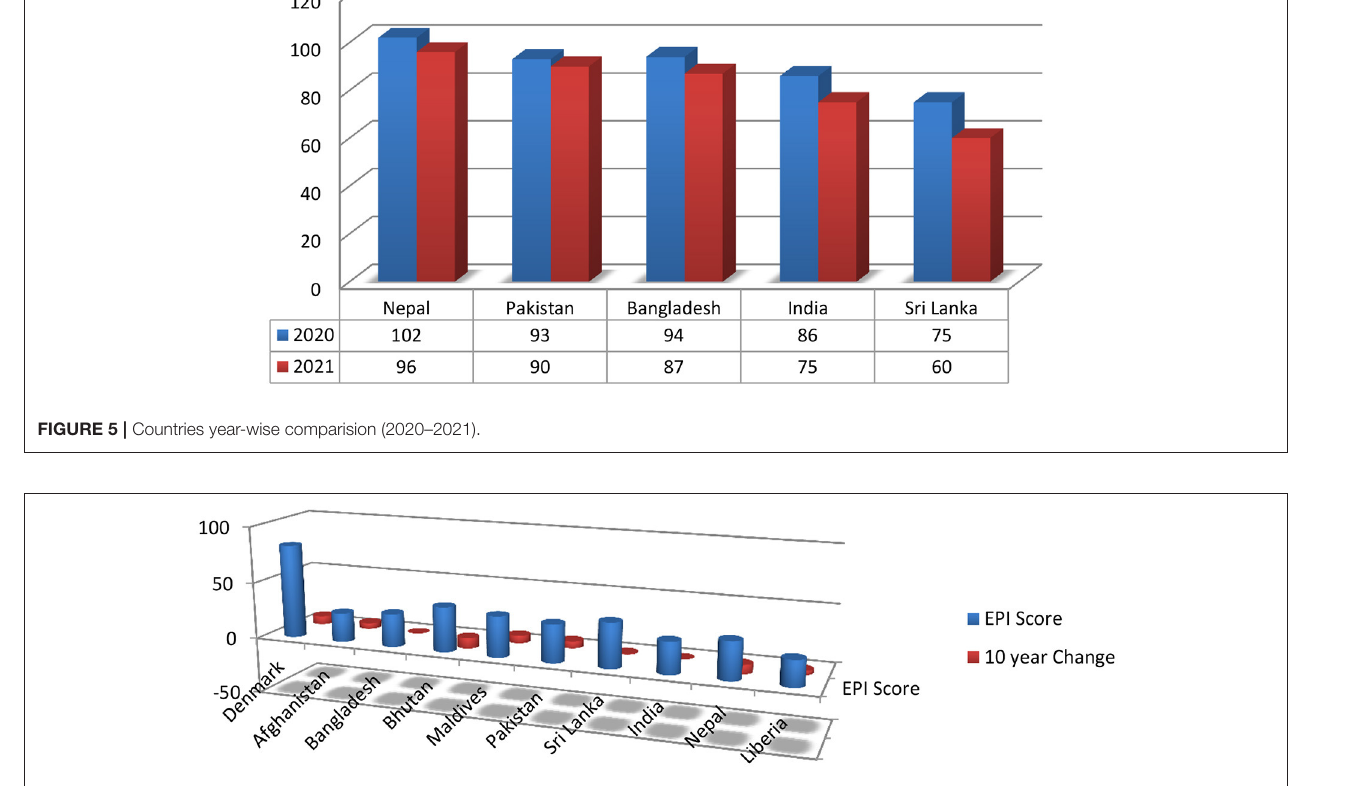
FIGURE 6 | South Asian Environment Performance Index (18). Sustainable Development (SDG) [(20), p. 252]. GT,